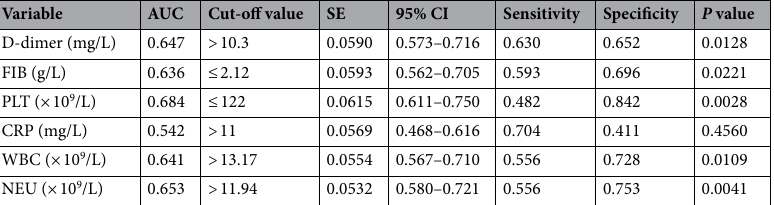
Table 2. Diagnostic value of D-dimer, FIB, PLT, CRP, WBC and NEU for in-hospital mortality. FIB, fibrinogen; PLT: platelet; CRP, C reactive protein; WBC, white blood cells; NEU, neutrophil.